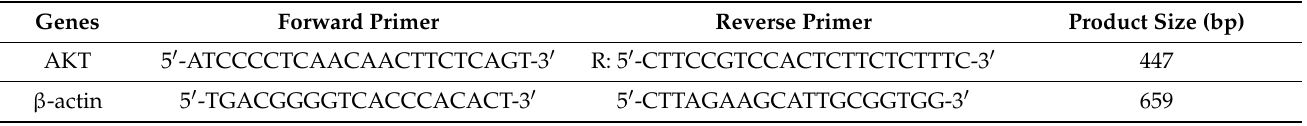
Table 1. AKT-308 primer sequences used for the polymerase chain reaction amplification.